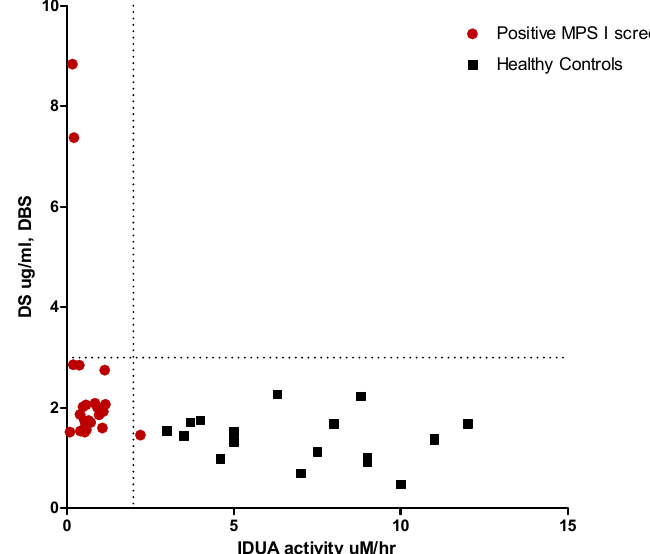
Figure 1. DBS-GAGs as second tier test for IDUA screening. Dermatan sulphate in DBS vs IDUA activity in newborns with suspicion of MPS I and healthy neonates.